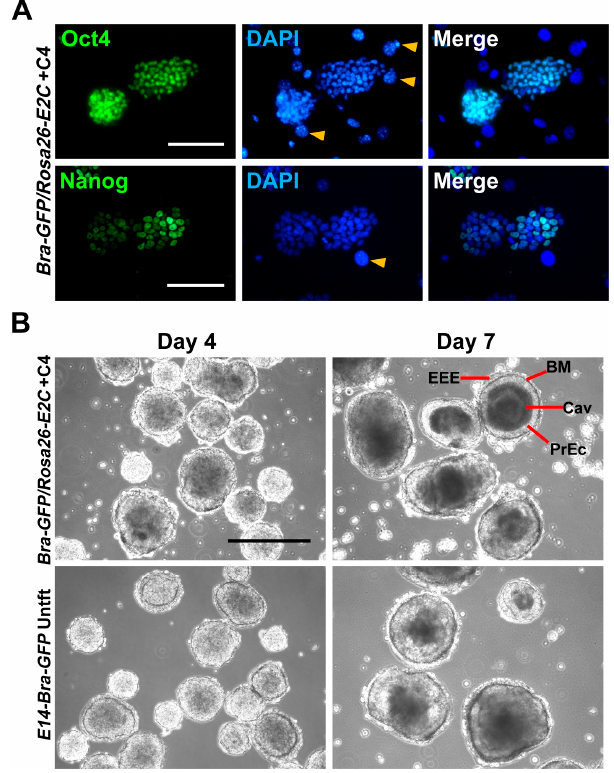
Figure 4. ( A ) Expression of stemness markers Oct4 and Nanog was confirmed by immunofluorescent staining of Bra-GFP/Rosa26-E2C mESC clone +C4. All samples were counter-stained with DAPI. Yellow arrow heads show STO feeder cell nuclei; ( B ) Differentiation potential of clone +C4 was confirmed by typical EB formation. Cells were seeded in suspension culture dishes up to day 7. PrEc, primitive ectoderm; EEE, extraembryonic endoderm; BM, basement membrane; Cav, cavity. Scale bars, 100 µm ( A ); 400 µm ( B ).